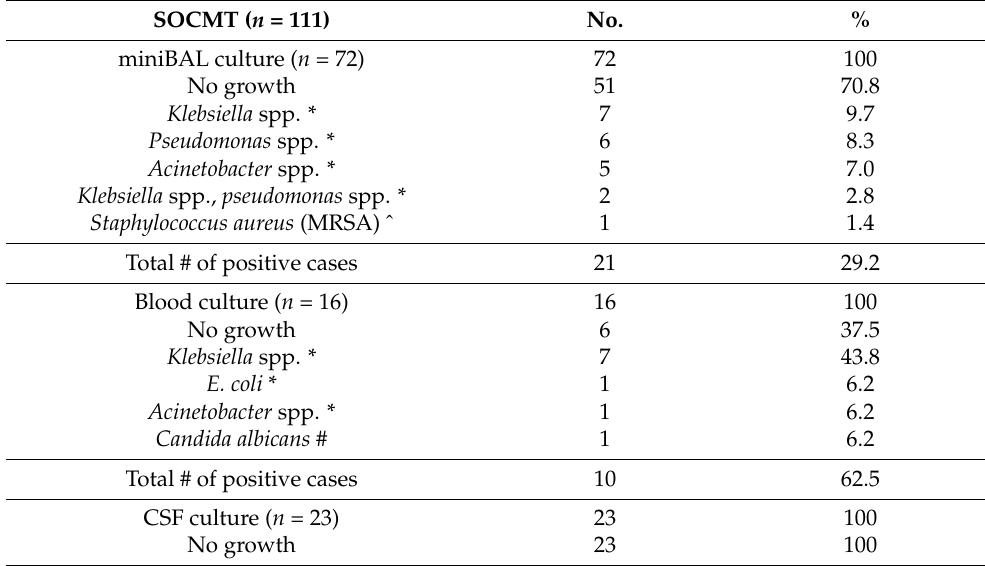
Table 1. Distribution of pathogens isolated by standard of care microbiology testing (SOCMT).